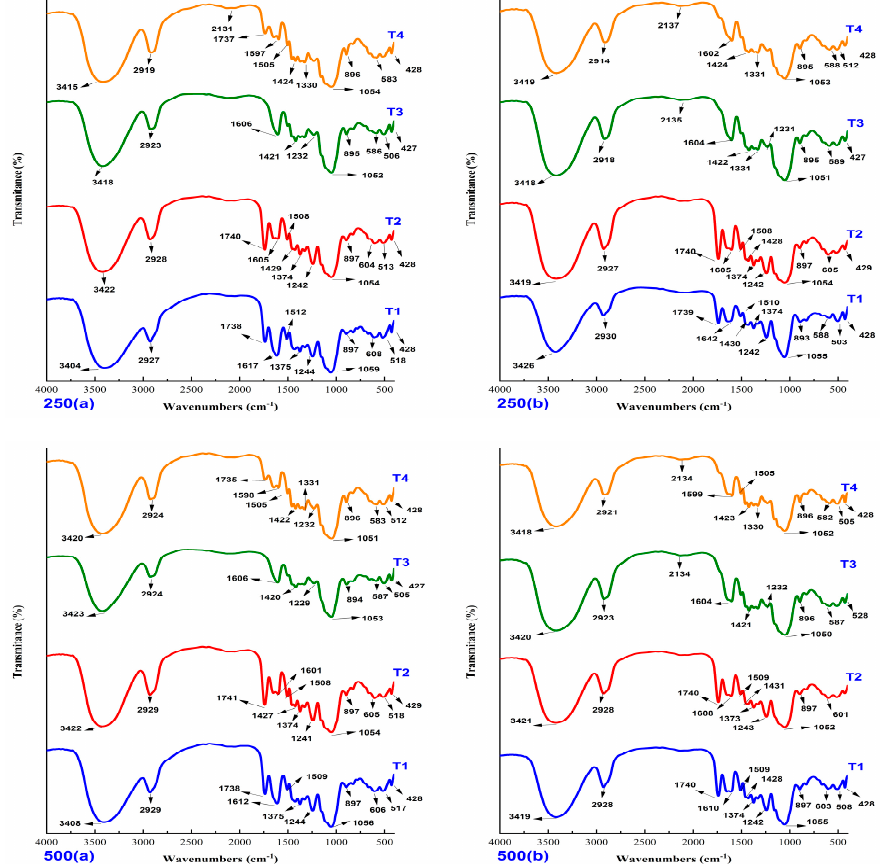
Figure 8. FTIR infrared spectra of the 250 and 500 µ m fractions, before ( a ) and after ( b ) the biosorption process.